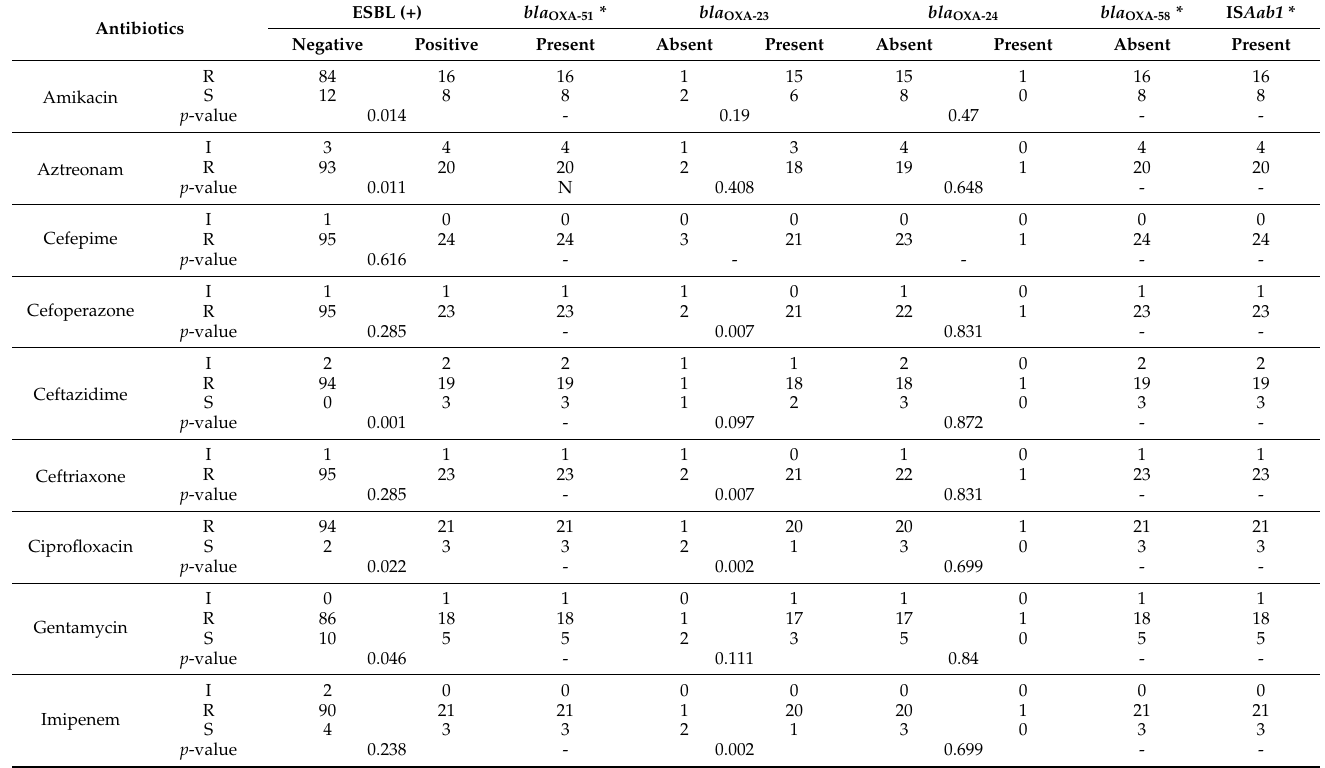
Table 2. Distribution of the CHDLs OXA type genes bla OXA-51, bla OXA-23 , bla OXA-24 , bla OXA-58 and the insertion sequence IS Aba1 among 24 ESBL-positive A. baumannii isolates and their antibiotic suitability test